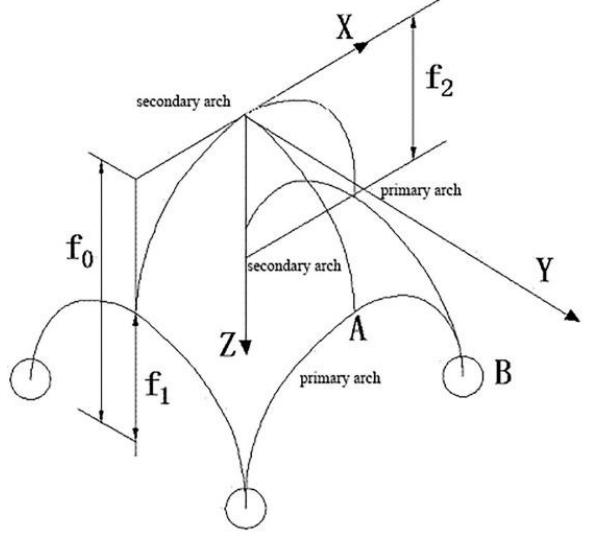
Figure 1. Primary and secondary